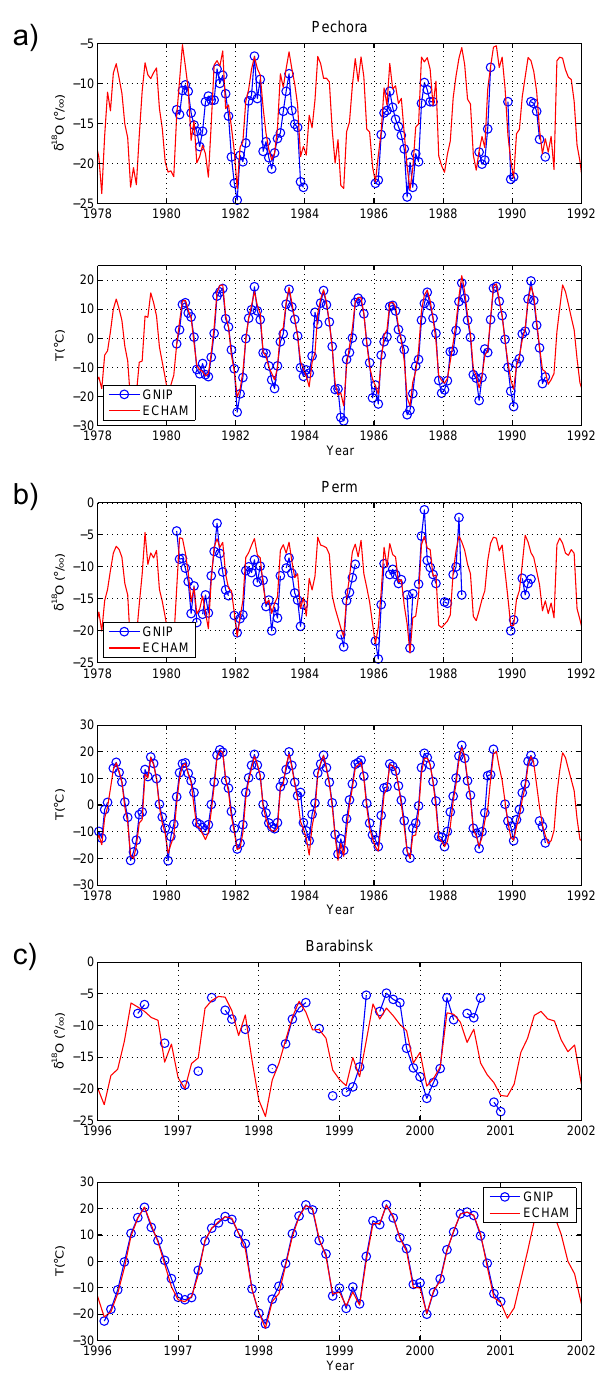
Figure 5. Observed versus modelled monthly δ 18 O values in pre- cipitation for the period 1980–2000. Measurements of 3 GNIP sta- tions located in western Siberia are plotted as blue circles: (a) Pe- chora, (b) Perm, (c) Barabinsk. The red line shows ECHAM5-wiso results corresponding to the same locations. Also shown are ob- served (blue) and modelled (red) surface temperatures.